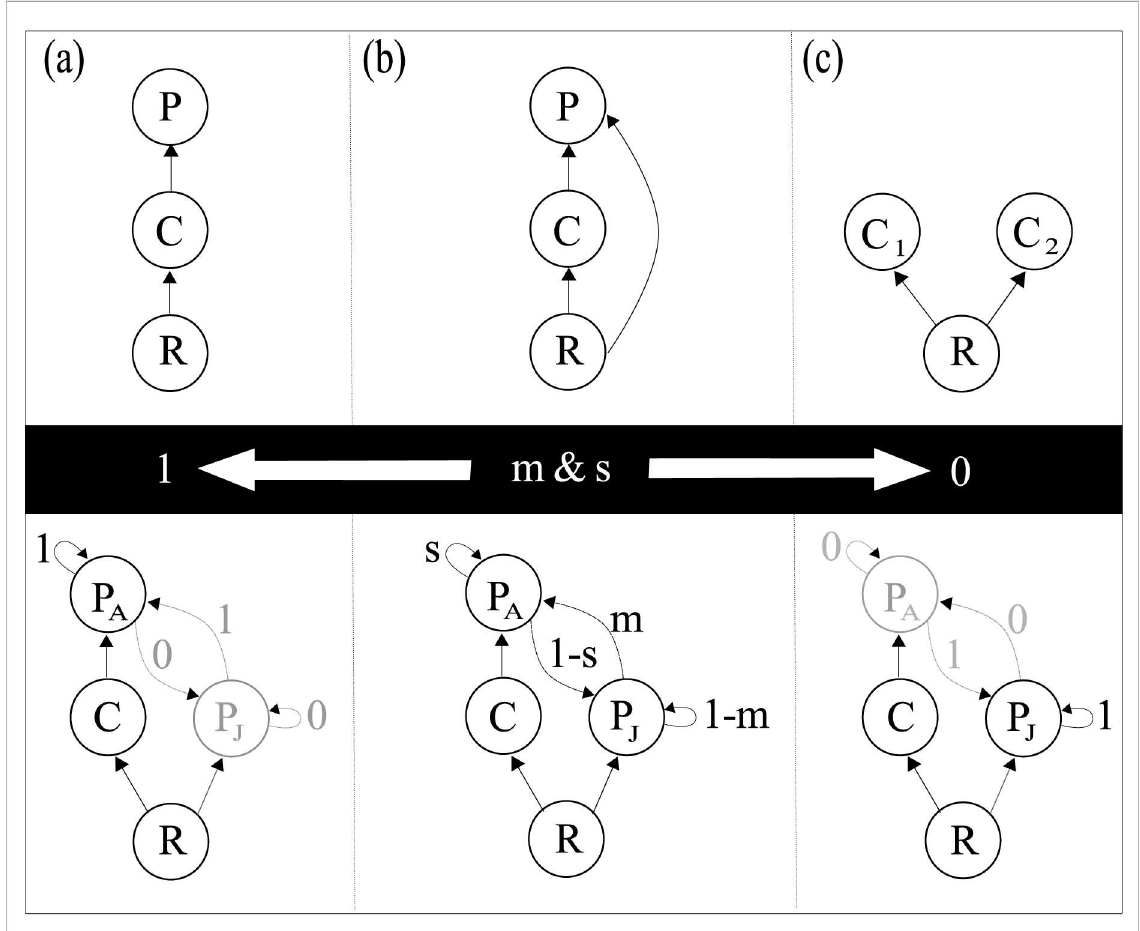
Fig 1. Nested stage-structured modules and their unstructured counterparts. The life-history intraguild predation (LHIGP) modulewhen m and s are equal to 1 (a) is reducedto the straight chain food web module. Somewhere in between(b) the LHIGP modulewill have equivalentdynamicsto the intraguildpredationmodule;when m and s are equal to 0 (c) the LHIGP moduleis reducedto the